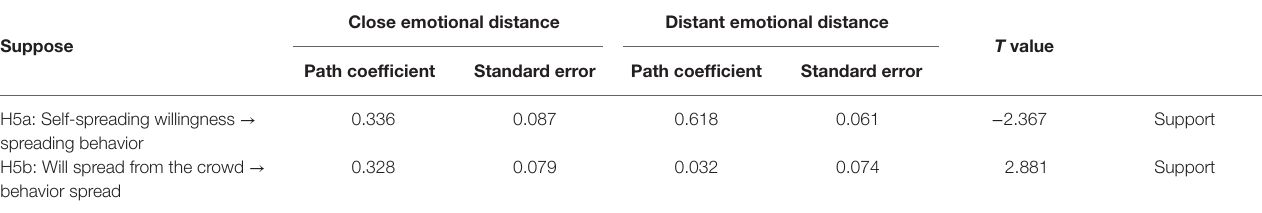
TABLE 3 | Verification of the moderating effect of emotional distance.